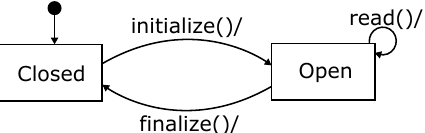
Figure 25. Protocol state machine